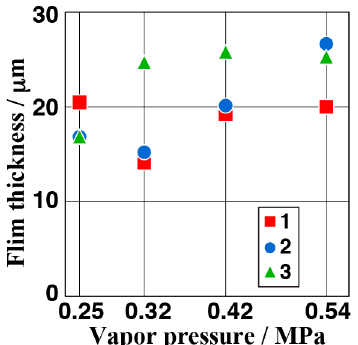
Figure 4. Cross-sectional image ( a ) and elemental mappings of the cross-sections ( b ), ( c ), ( d ) for Mg, Al, and O of the sample (C) treated at 0.42 MPa.